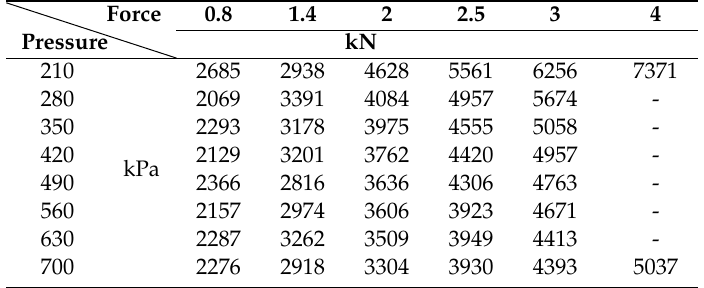
Table 5. Surface area values resulting from testing the ASFT tire-smooth tire ASTM (results in mm 2 ).